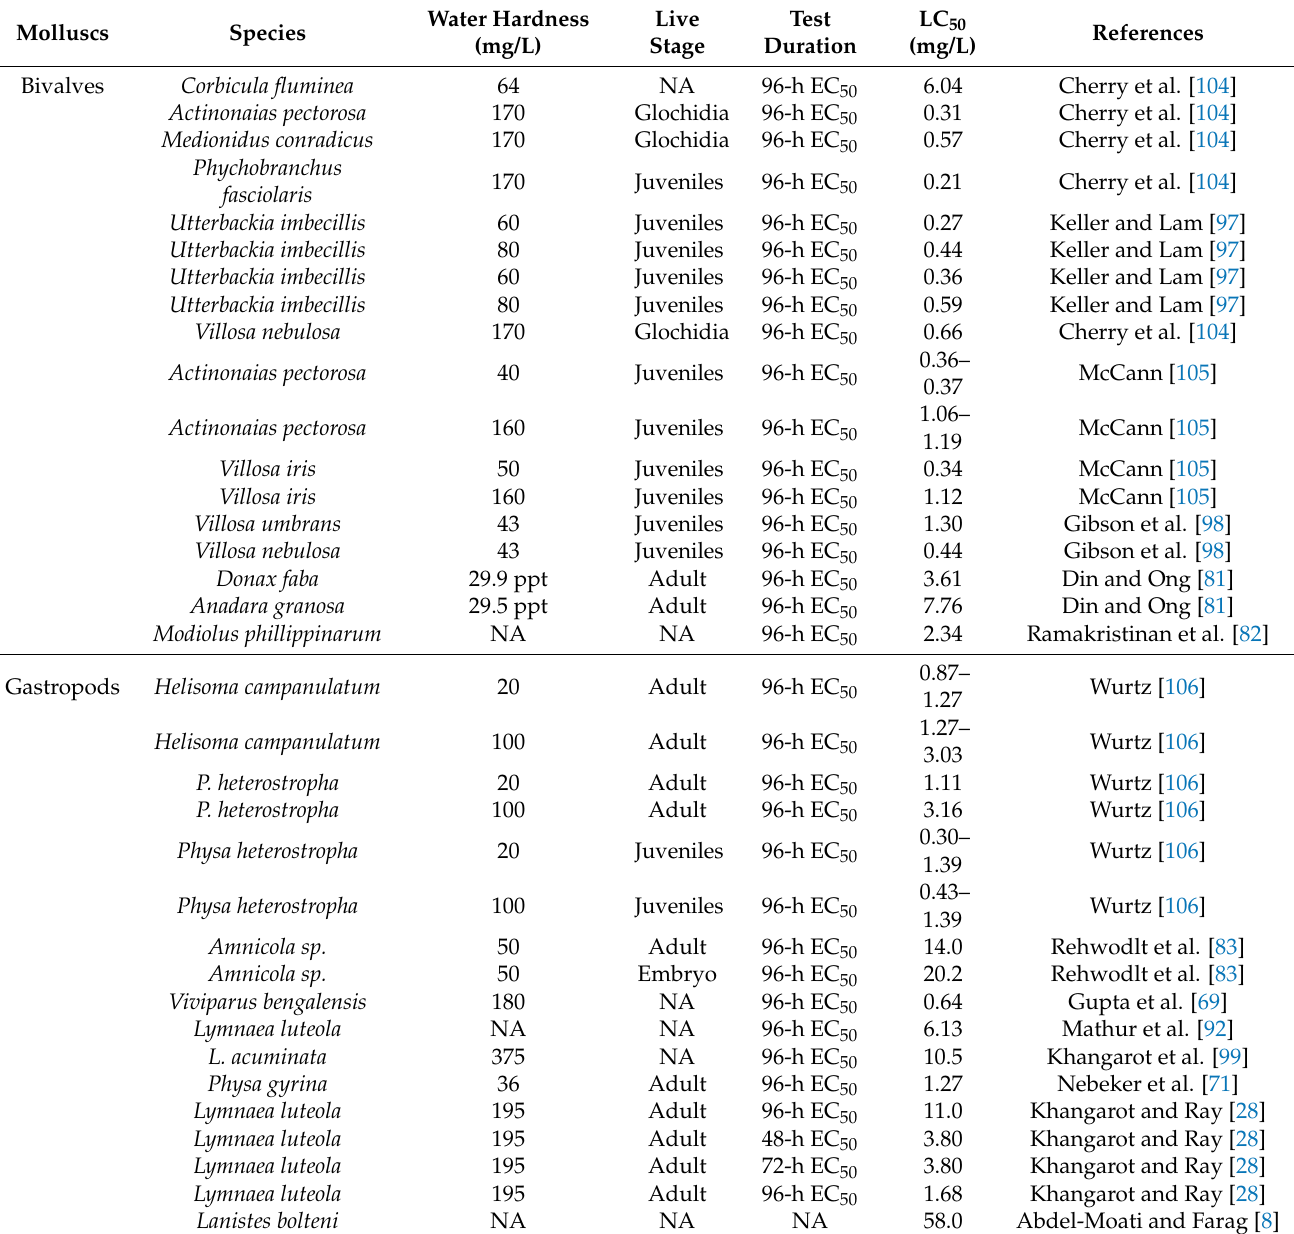
Table 6. Comparison of LC 50 values (mg/L) of Zn in Pomacea insularum with other mollusks reported in the